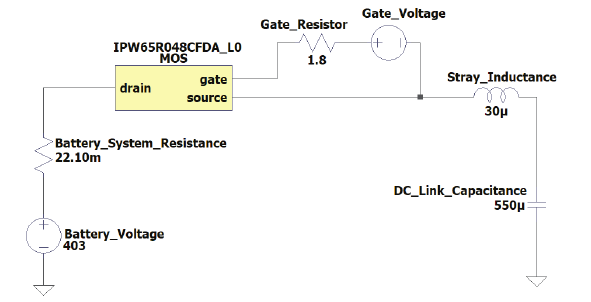
Fig. 4. Simulation circuit with semiconductor.